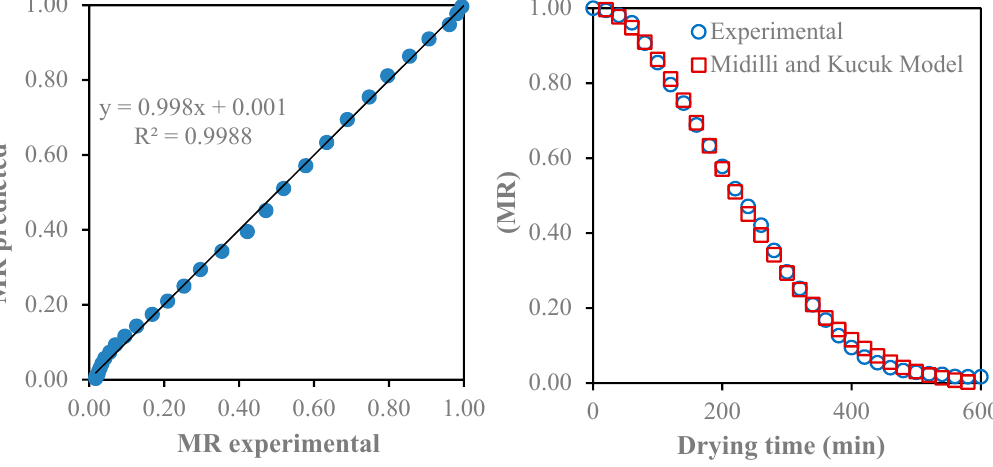
Figure 6. Validation of experimental and predicted moisture ratio values from the Weibull Distribution model. 3.4. Chromatic Coordinates The values of brightness L * and the chromaticity coordinates a * and b * to the fresh and dried sample of lettuce are shown in Table 3. After the drying process was completed it was observed that the values of L * between fresh and dried samples had no statistically significant differences ( p < 0.05), indicating that the drying process did not affect this parameter. However, a different behavior was taken to the values of a * and b * where statistically significant differences ( p < 0.05) were recorded to compare the values of the population of the fresh sample with the dry sample. Chromatic coordinate a * had a move from the green zone to the beginning of the red zone, which is indicative of the change of sign from negative to positive, while in the case of the chromatic coordinate b *, although the values